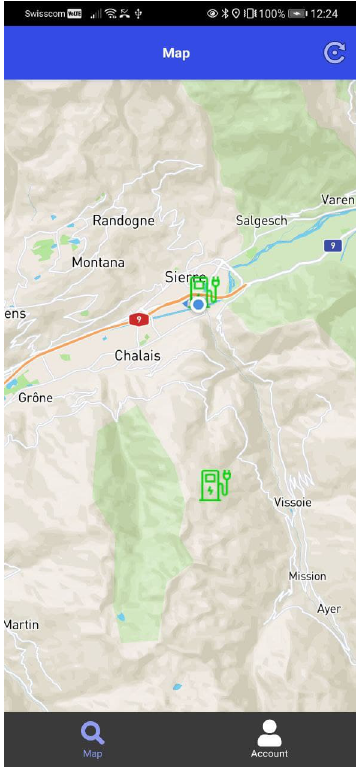
Figure 12. Map of charging stations.